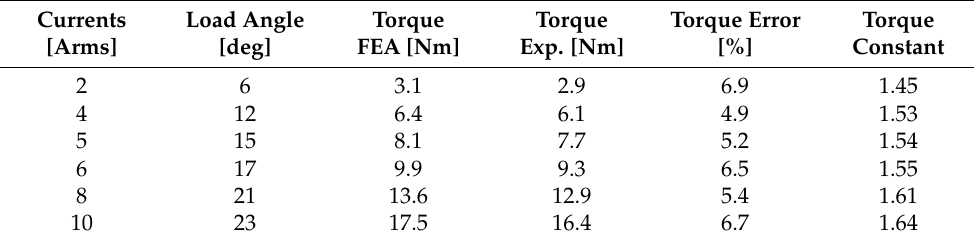
Table 9. Comparison of torque characteristics in relation to current for six-phase operation.